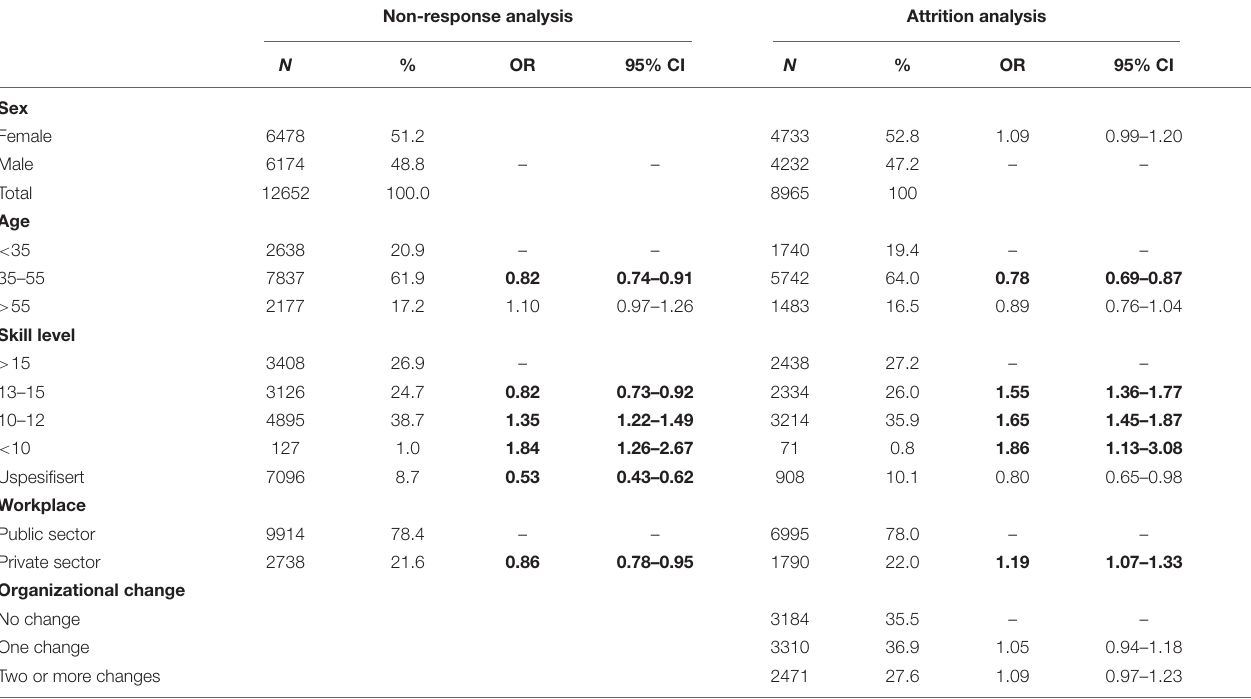
TABLE 2 | Non-response and attrition